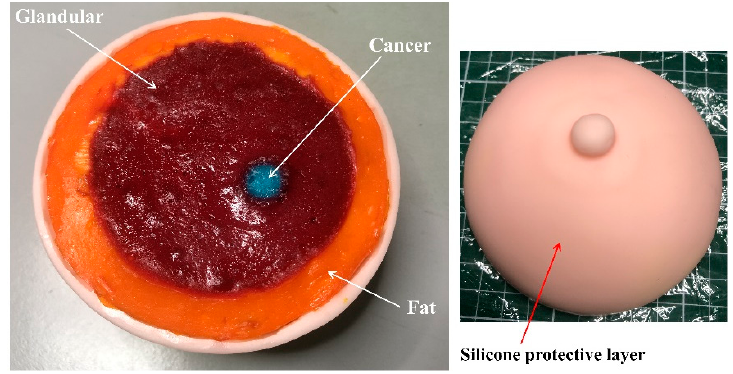
Figure 17. Heterogenous breast phantom prototype.